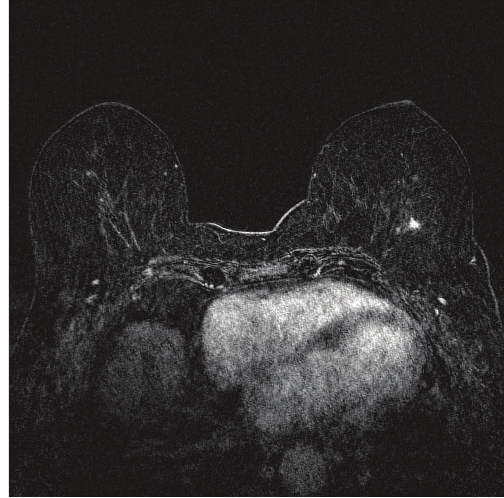
Figure 3: Subtraction MRI demonstrates a 2.1cm × 1.2cm enhanc- ing mass within the lingula, biopsy proven to represent extran- odal Castleman’s disease. Incidental note is made of a postbiopsy hematoma/seroma within the medial left breast from stereotactic biopsy of the pleomorphic calcifications demonstrated in Figures 1(a) and